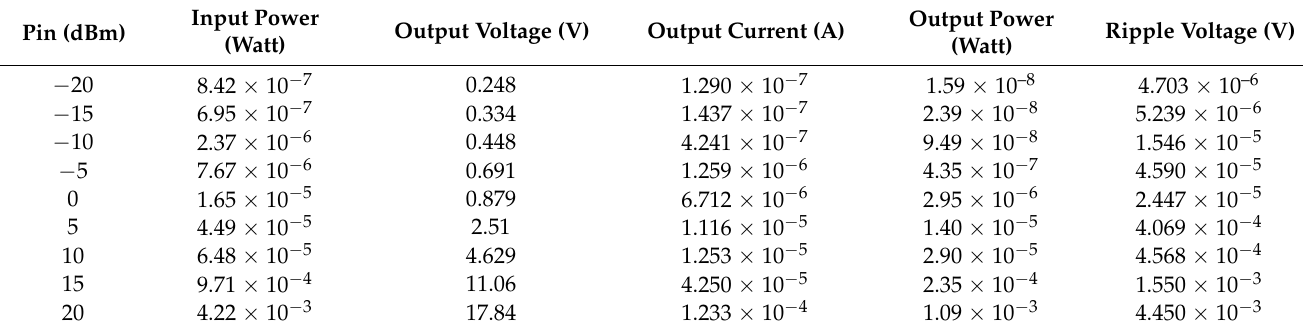
Figure 15. Output voltages with the number of stages of Cockcroft–Walton rectenna. Table 2. The simulated results for Cockcroft-Walton voltage multiplier